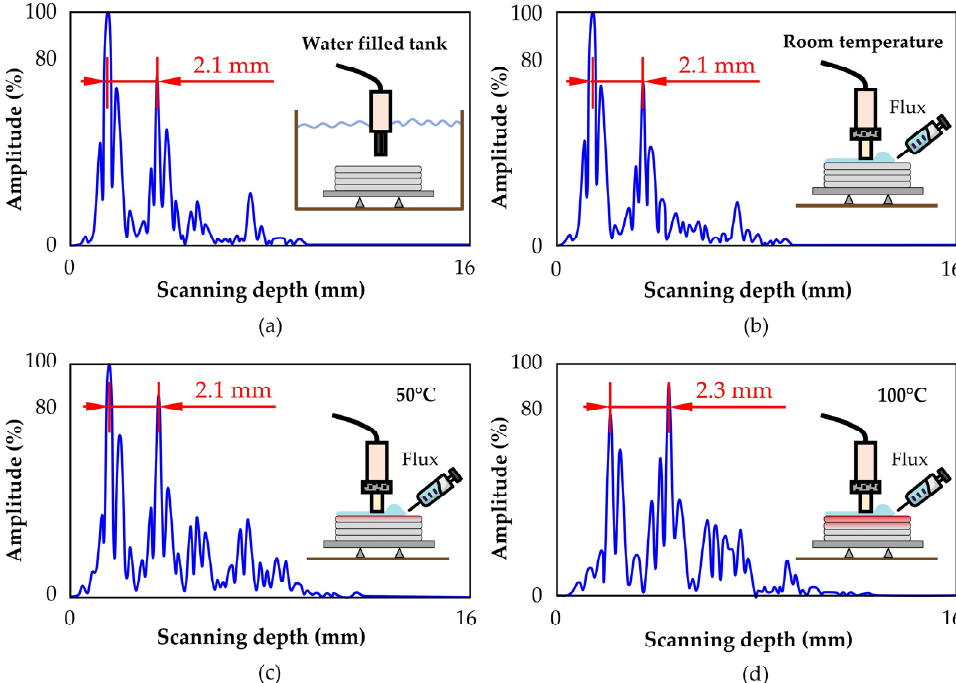
Figure 10. A-scans obtained by ultrasonic testing (UT) of 2 mm depth defects on deposited ER5356 aluminum walls using ( a ) UT by immersion in a water-filled tank and the proposed UT technique at ( b ) room temperature, ( c ) 50 °C and ( d ) 100 °C in the measuring regions.